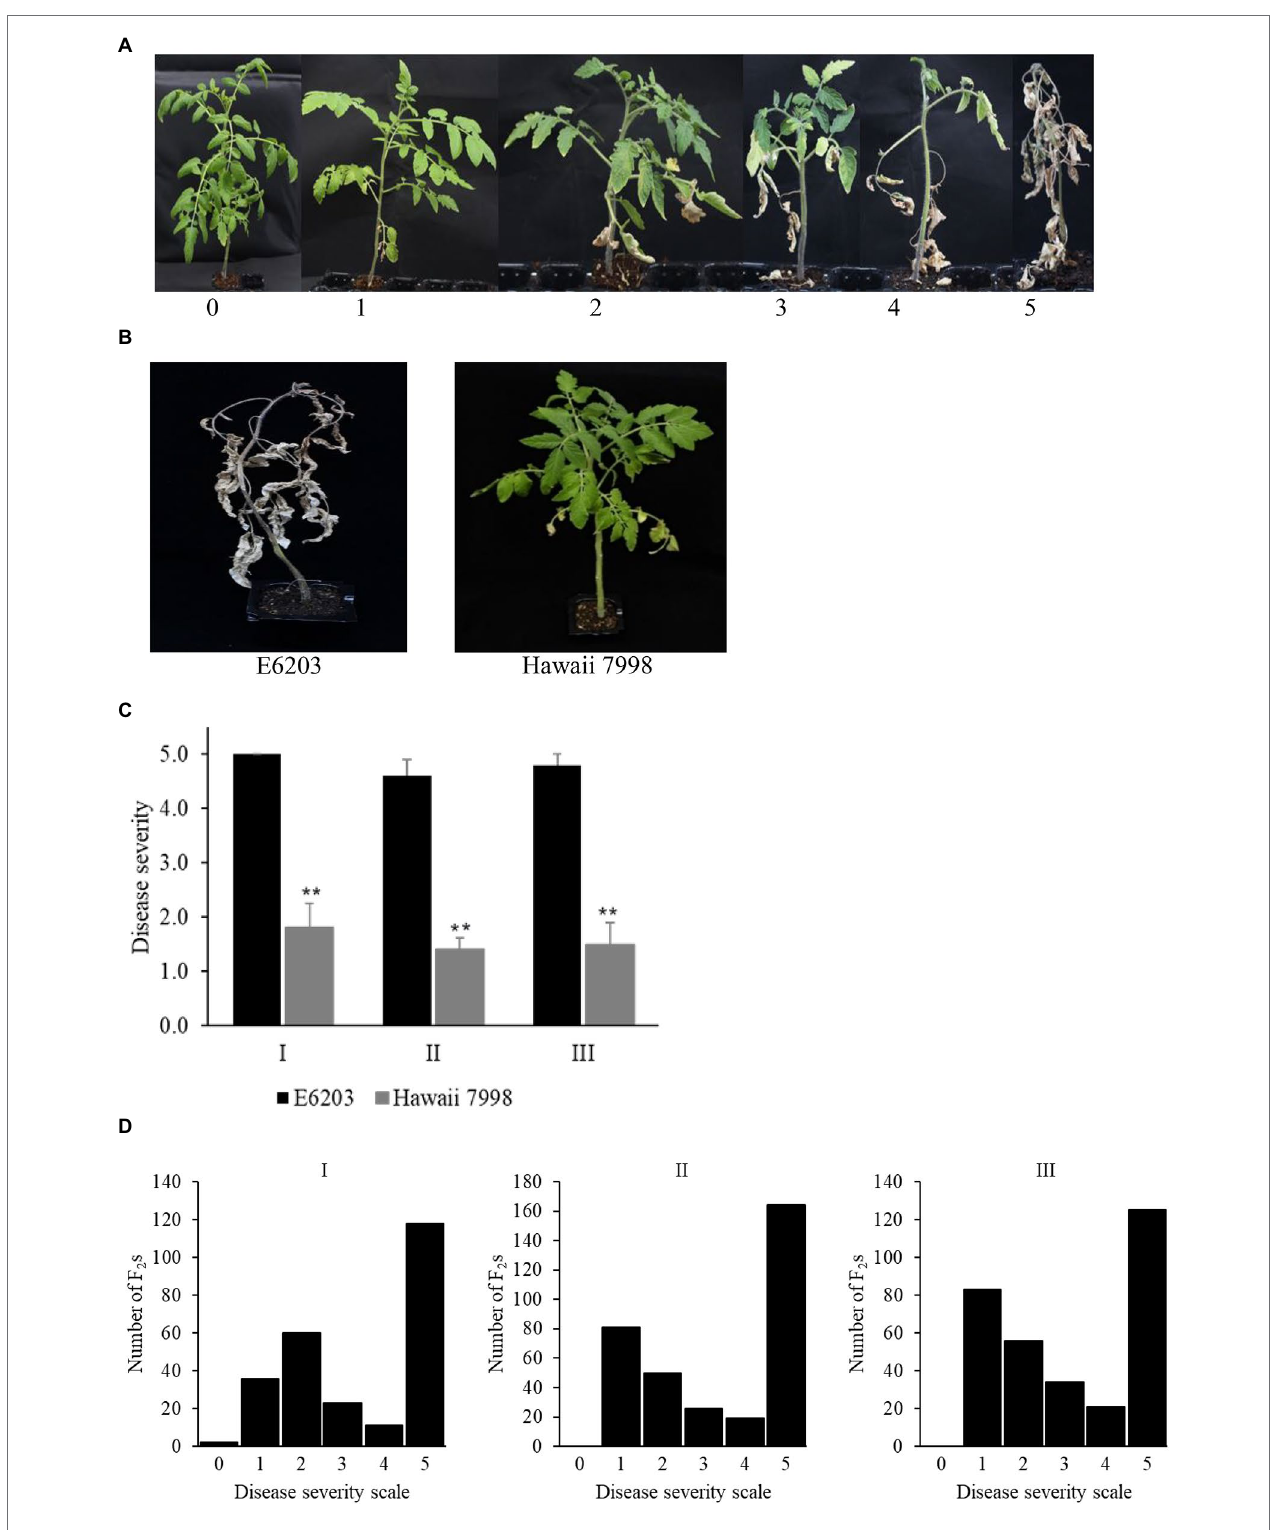
FIGURE 1 | Evaluation of parental lines and F 2 population for bacterial canker resistance. (A) Disease severity scale (0–5) at 5 weeks post-inoculation against Cm . (B) Phenotypes of susceptible “E6203” and resistant “Hawaii 7998” at 5 weeks post-inoculation against Cm . (C) Disease severity of “E6203” and “Hawaii 7998” against Cm inoculation in three independent experiments. The asterisks indicate a significant difference as determined by Student’s t-test at p < 0.01. (D) Frequency distribution of disease severity scales of the F 2 population in experiment-I, II, and